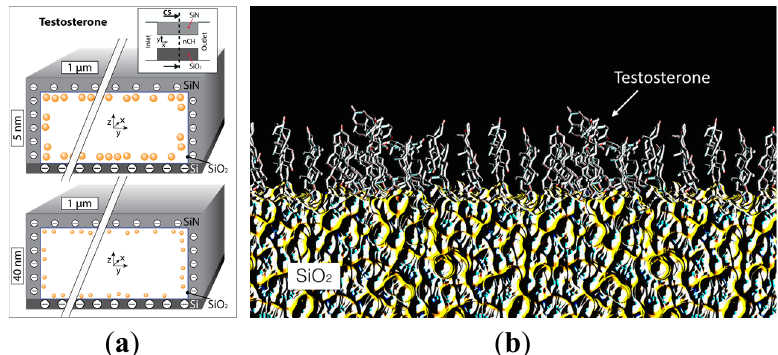
Figure 5. Average cumulative release of testosterone for both 5 (blue) and 40 (red) nm nanochannel membranes. The grey lines highlight the standard deviation. Theoretical fitting value is report for both releases.